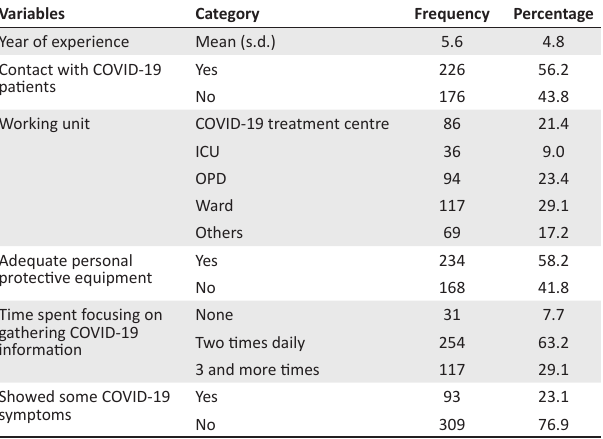
TABLE 2: Clinical and COVID-19 related description of the frontline healthcare workers in Ethiopia, 2021 ( n = 402).